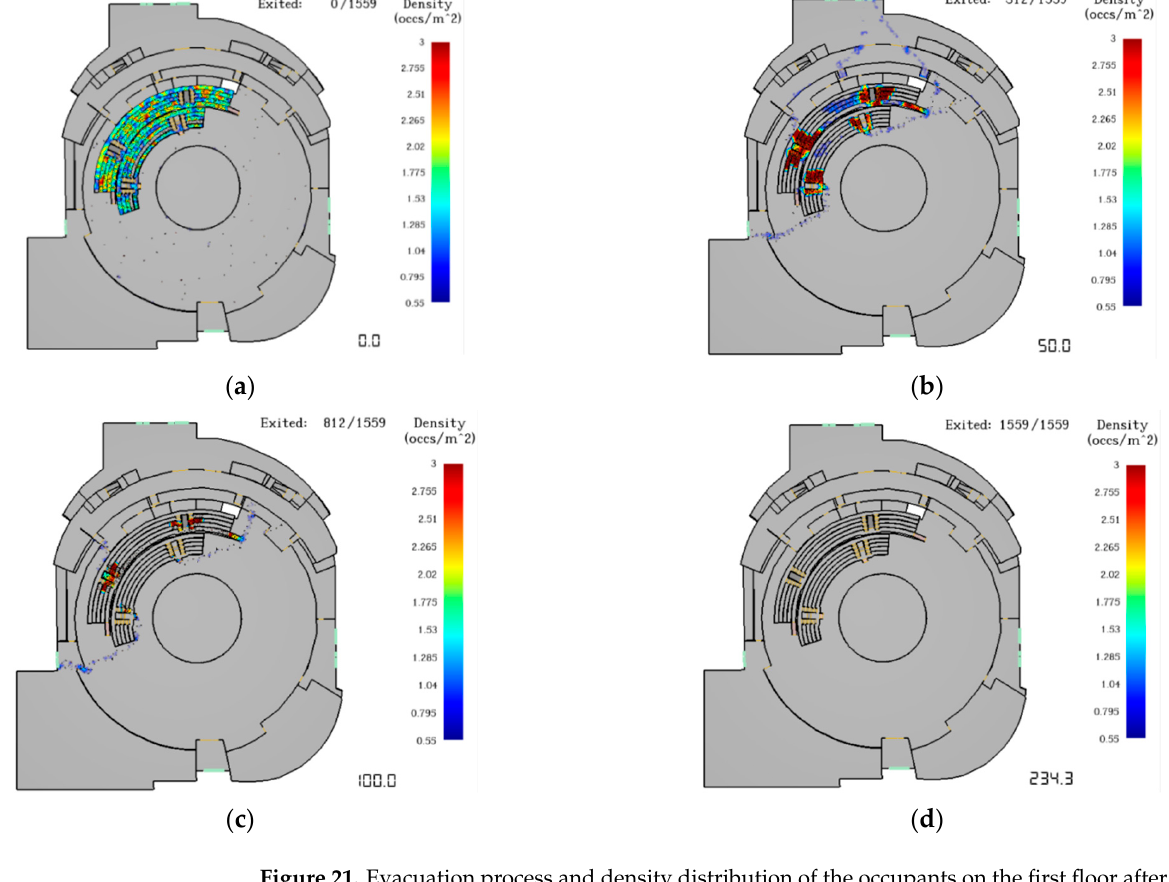
( d ) Figure 21. Evacuation process and density distribution of the occupants on the first floor after add- ing emergency evacuation stairs. ( a ) Occupant density at 0 s; ( b ) occupant density at 50 s; ( c ) occu- pant density at 100 s; ( d ) occupant density at 234.3 s.